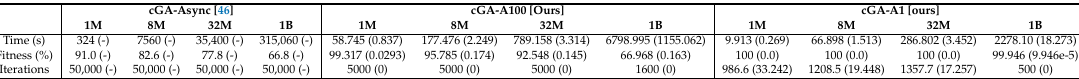
Table 5. Asynchronous binary cGAs: comparison on the OneMax problem (mean across 10 runs, std. dev. in parentheses). The symbol ’-’ indicates data not provided in